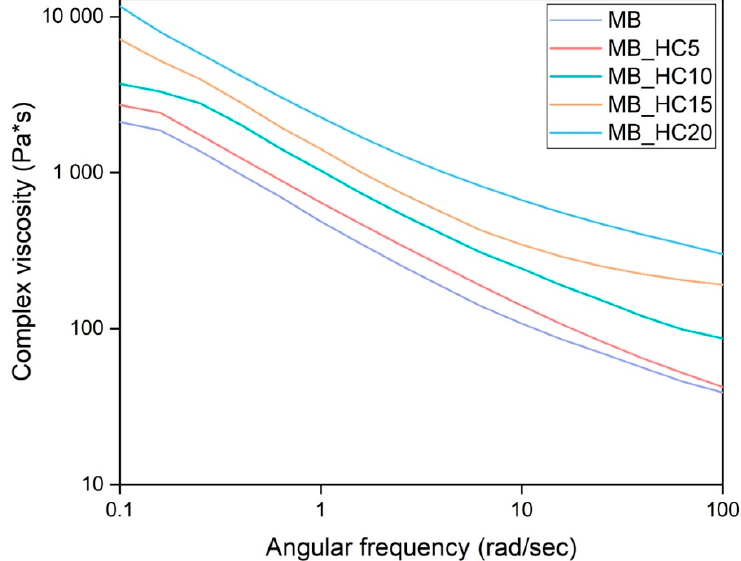
Figure 2. Complex viscosity of pure MB and its HC composites.